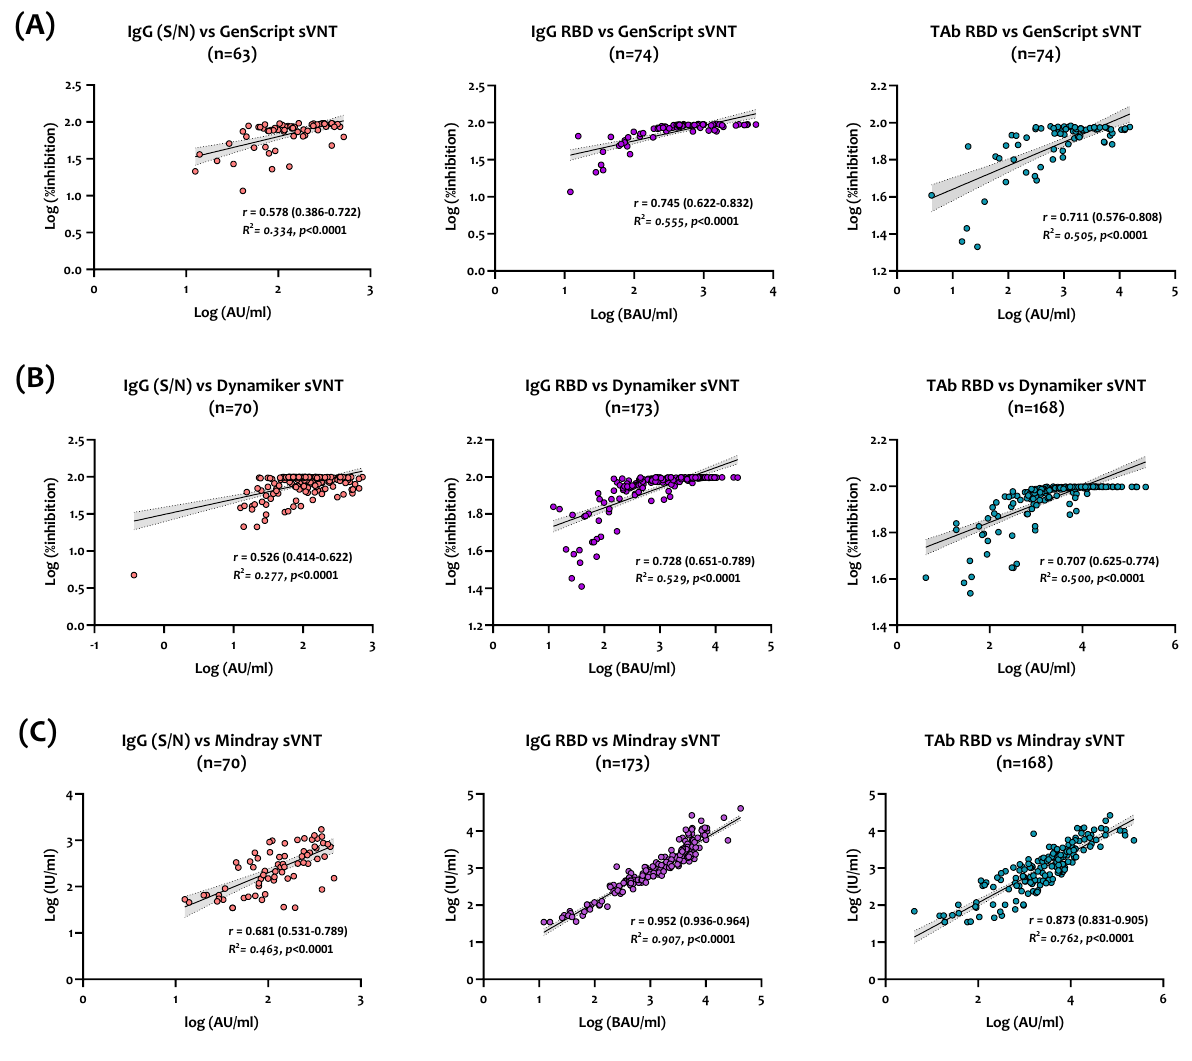
Figure 3. Correlation and linear regression analysis between each sVNT and serological assays detecting anti- SARS-CoV-2 binding antibodies, including anti-S and N IgG antibodies (orange), anti-RBD IgG (violet), and anti-RBD total antibodies (turquoise) for samples collected from previously infected and vaccinated individuals. ( A ) GenScrip sVNT, ( B ) Dynamiker sVNT, ( C ) Mindray NTAb sVNT. Presented data show the log-transformed values of quantitative results obtained by each